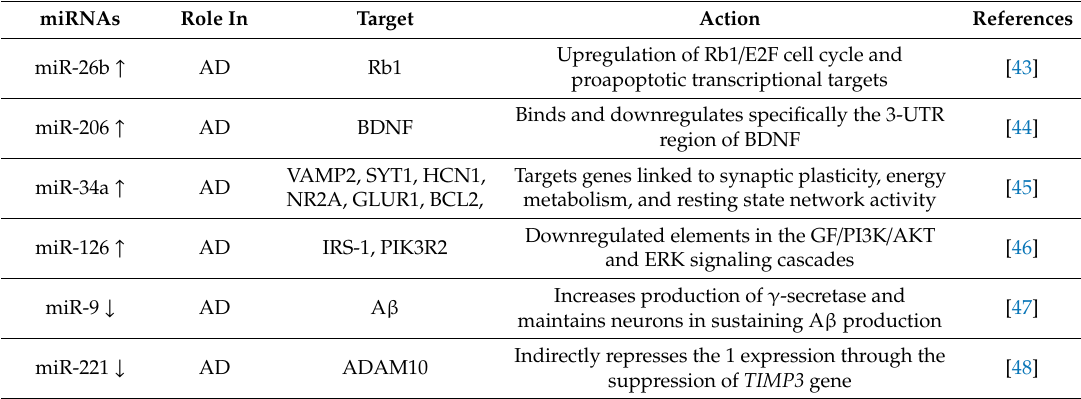
Table 1. The most representative miRNAs involved in neurodegenerative